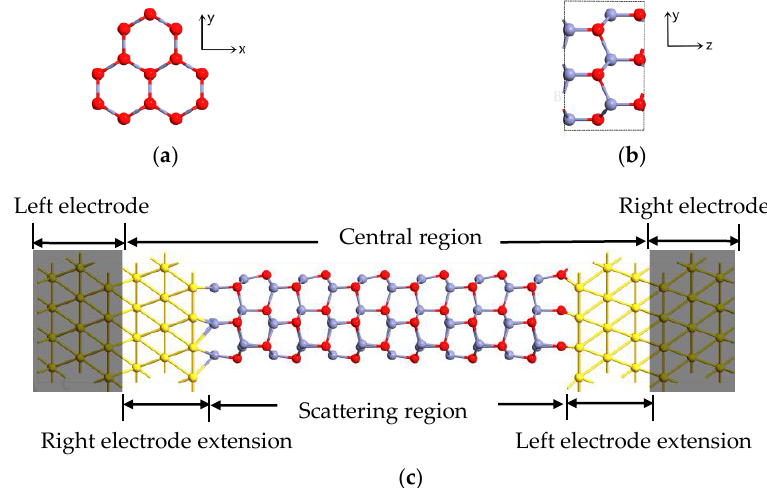
Figure 1. Schematic of the two-probe device structure model. ( a ) The x – y plane of the unit cell. ( b ) The z – y plane of the unit cell. ( c ) The shadow areas at the ends of the model indicate the left and right electrodes, the channel length is indicated by the number of unit cells of the ZnO (Zn and O atoms are denoted with gray and red, respectively).